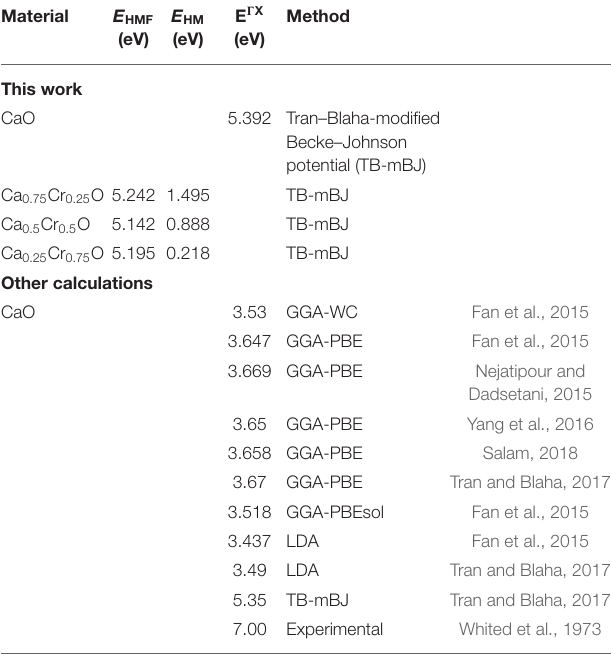
TABLE 2 | Computed band gaps such as indirect band gap ( E Ŵ x ) for CaO, half-metallic ferromagnetic (HMF) gaps ( E HMF ), and half-metallic (HM) gaps ( E HM ) of minority-spin bands for Ca 1-x Cr x O at concentrations x = 0.25, 0.5, and 0.75 with other theoretical and experimental